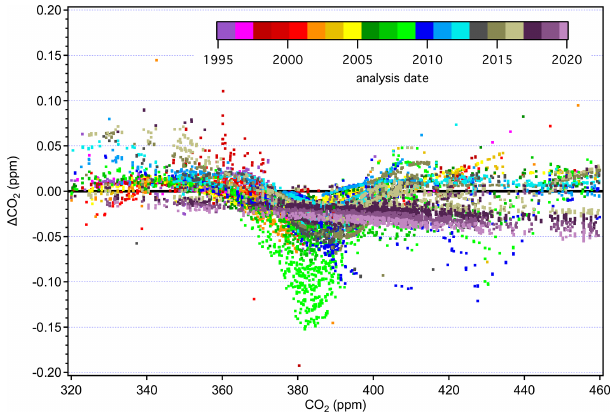
Figure 14. Scale conversion bias seen in tertiary standard assign- ments when using the linear scale conversion, shown as the differ- ence between the linear scale conversion and the reprocessed values.